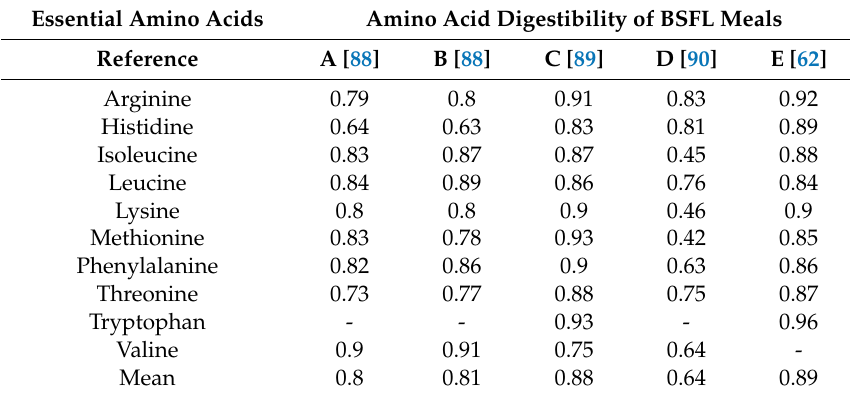
Table 4. Amino acid digestibility of BSFL meal estimated by di ff erent